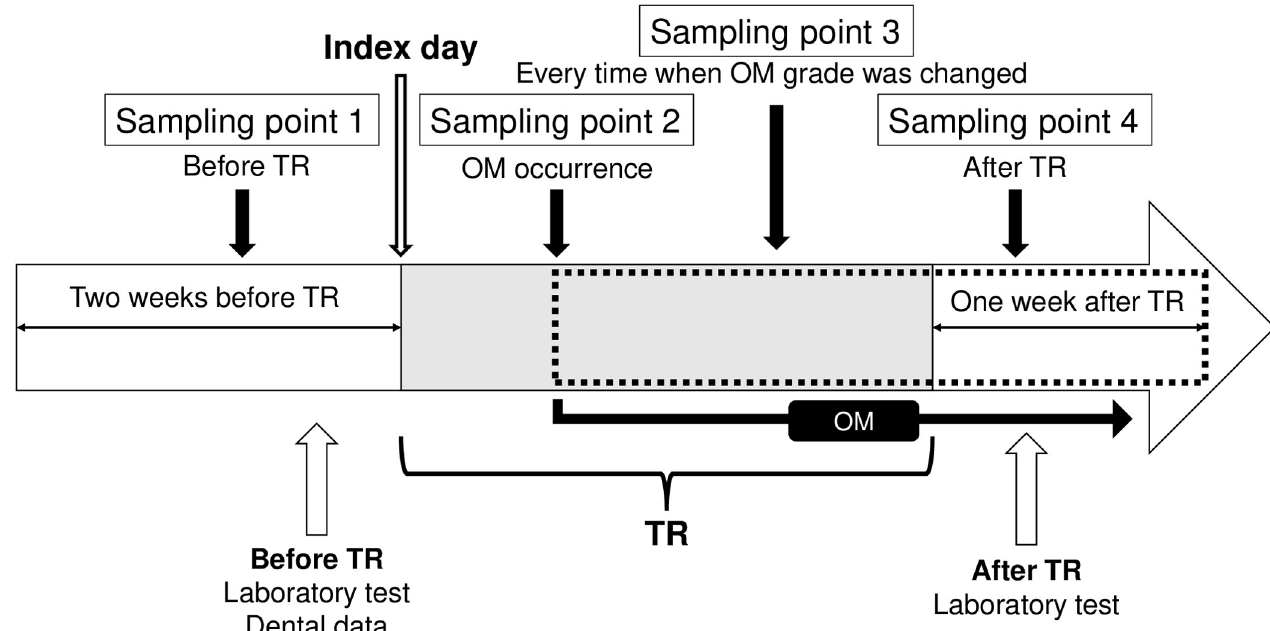
Fig 1. Sampling schedule. The saliva is collected at the sampling points 1–4. Sampling point 1: before TR, sampling point 2: when OM occurred, sampling point 3: when OM grade changed, and sampling point 4: after TR. Abbreviations: TR, treatment; OM, oral mucositis.